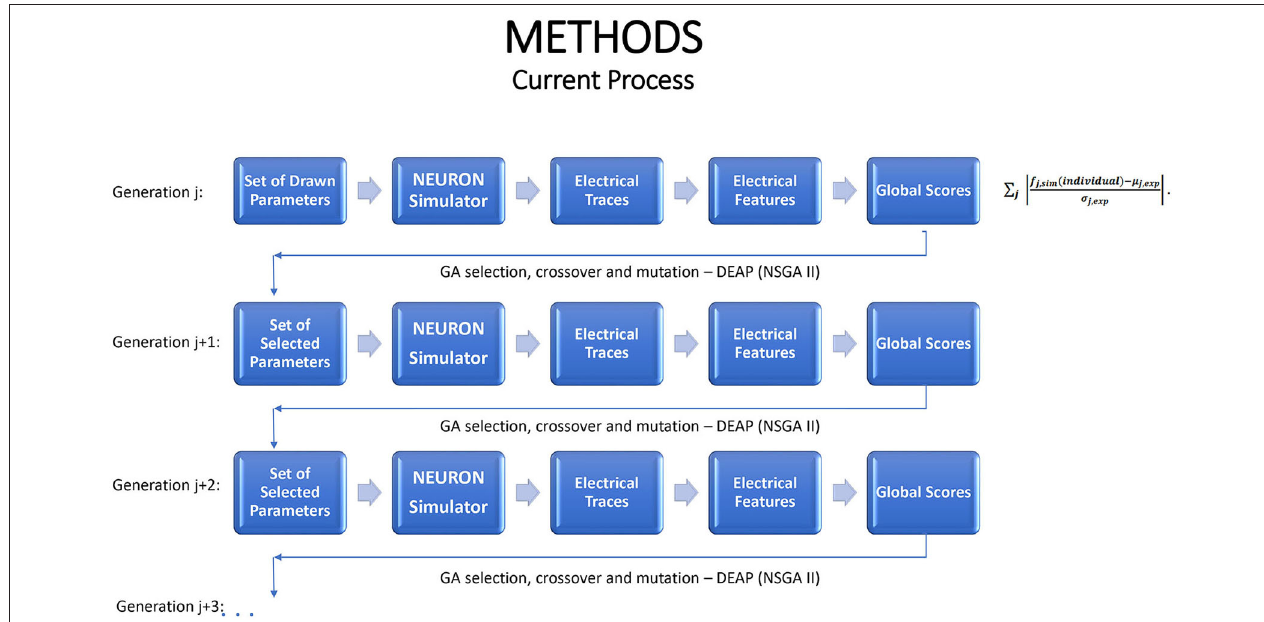
FIGURE 1 | A schematic portrayal of how the genetic algorithm advances from one generation to the next, when used for multiple objective optimization in conjunction with the NEURON simulator. Each generation should lead to increasingly favorable individuals.